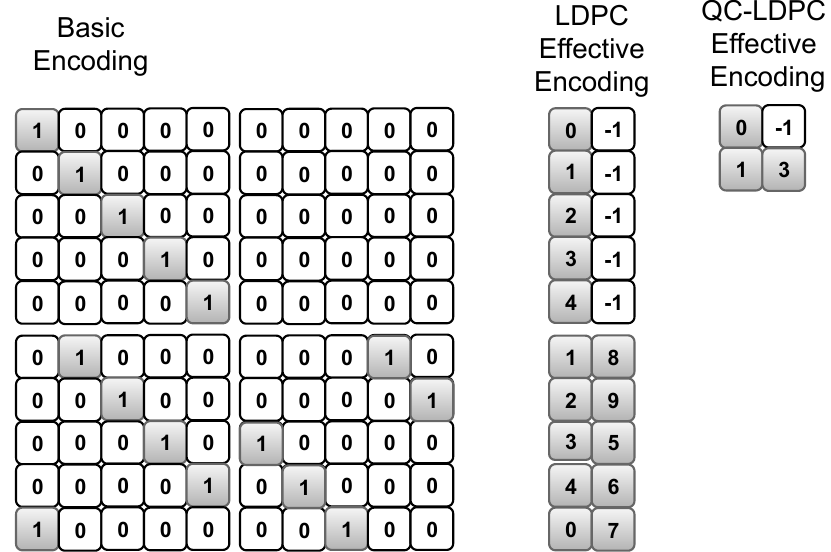
Figure 3. Illustration of the size of the H matrix with three different representations in the microcon- troller memory.